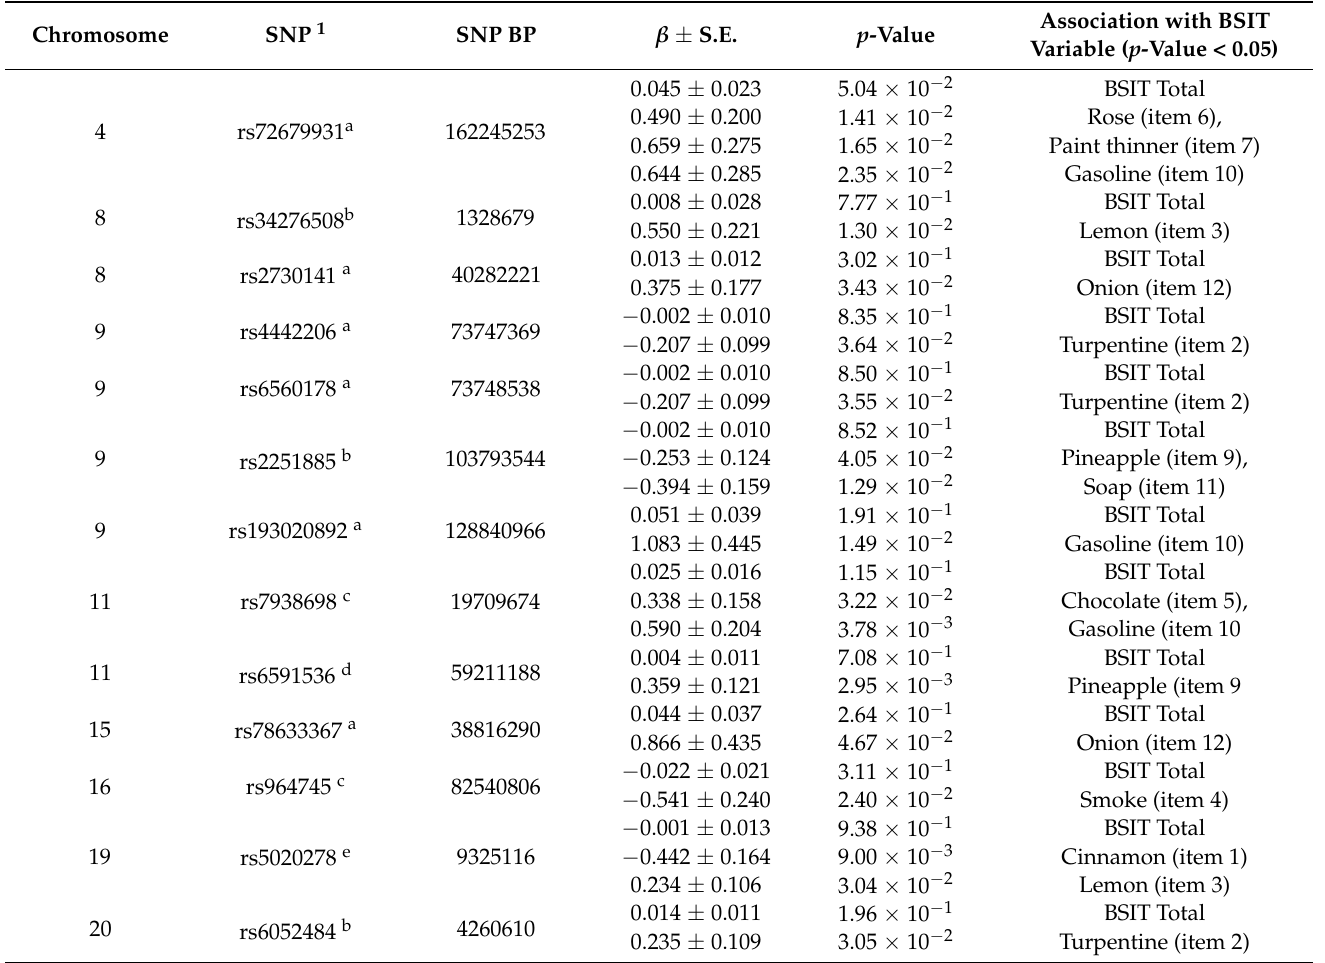
Table 4. Thirteen SNPs identified from prior studies were nominally significant (unadjusted p -value < 0.05) in the current study with individual BSIT items. Results for total BSIT score are also